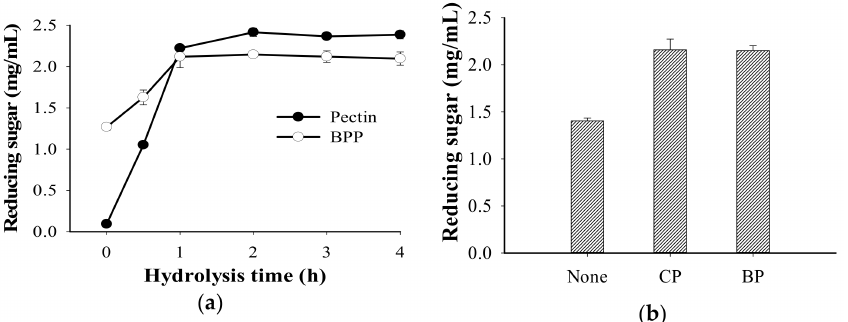
Figure 6. The hydrolysis of BPP and pectin catalyzed by TKU050 pectinase ( a ); BPP catalyzed by commercial pectinase and TKU050 pectinase ( b ). BPP, banana peel powder; CP, commercial pectinase from A. niger ; and BP, B. amyloliquefaciens TKU050 pectinase. All error bars are the ± SD (standard deviation) of three different experiments.